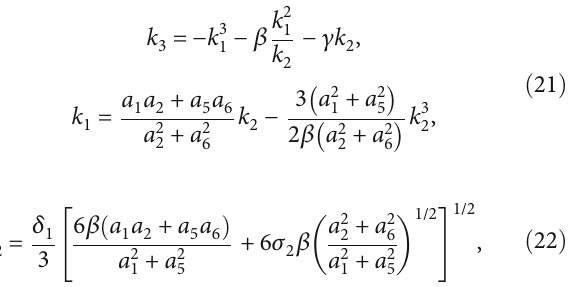
= 1/20 , a = 2 , k = l = 1/10 , a 1 5